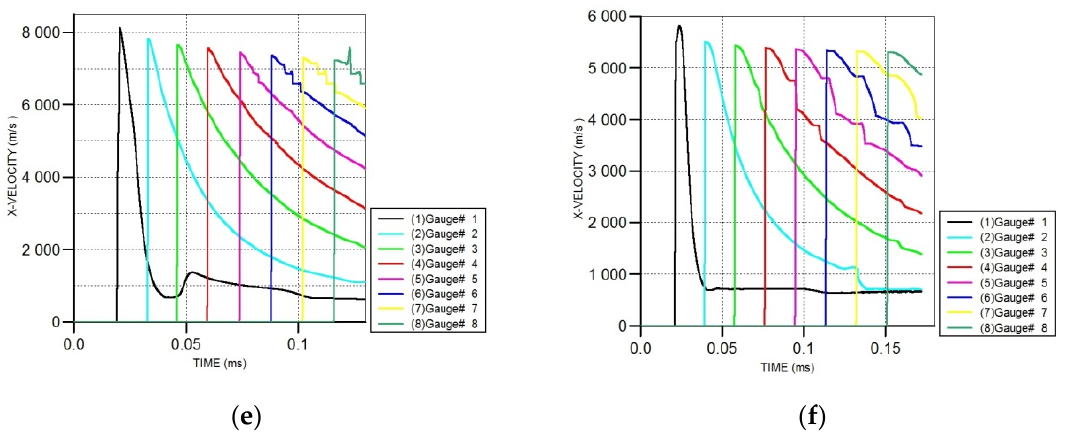
Figure 5. The variation curves of the jet velocity at gauges. ( a ) Cylindrical nickel liner. ( b ) Cylindrical tungsten liner. ( c ) Cylindrical tantalum liner. ( d ) Cylindrical steel 4340 liner. ( e ) Cylindrical copper liner. ( f ) Classical conical-shaped